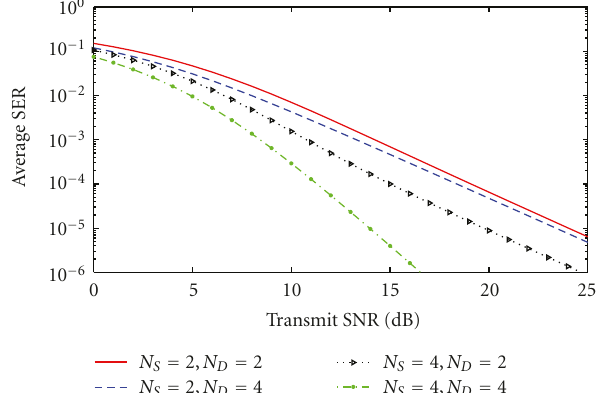
Figure 4: Average SER of the BPSK system with di ff erent antenna configurations.